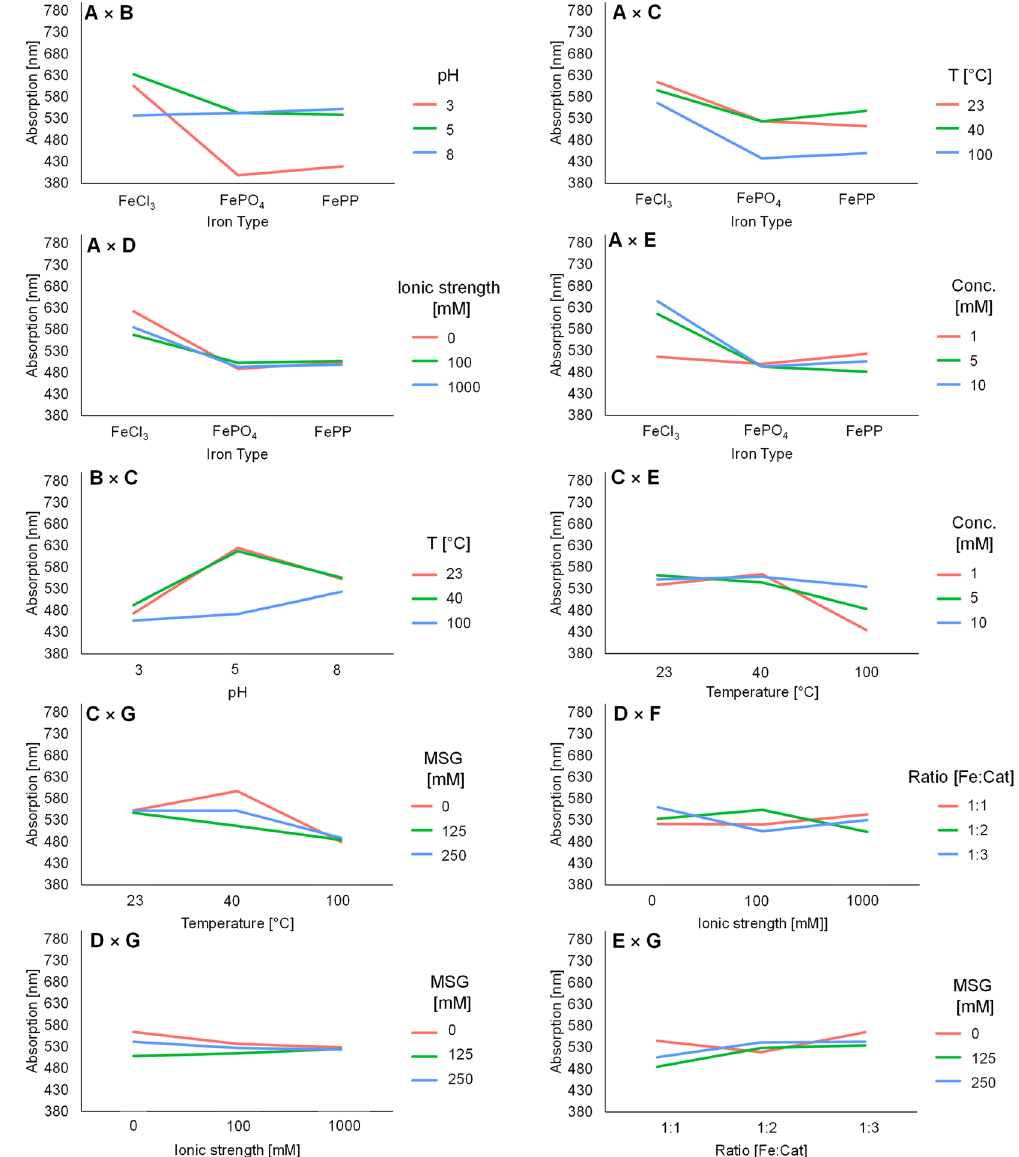
average maximum absorption wavelength is indicated on the y-axis. Letters indicate the factors corresponding with Table